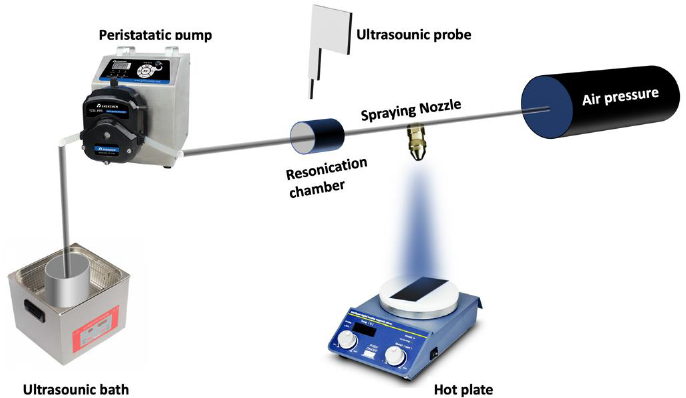
Figure 2. Schematic diagram of the spray pyrolysis system used to prepare thin films out of the graphene@WS 2 .